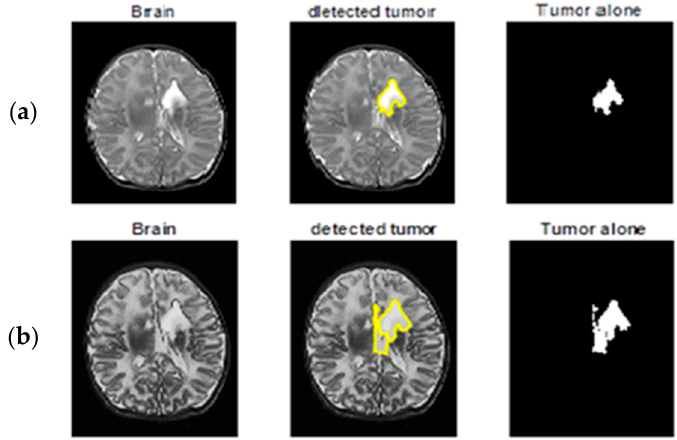
Figure 12. In the figures, the first image in the is the original image, the second image is the segmentation result of the first one, and the third image represents the extraction of the tumor succeeding segmentation. Similarly, in Figure 12, row 2 ( b ), the first figure is the preprocessed result of the original image, and the second and third images are same as above. From the third part, it is visualized with ease that the result of the tumor extraction does have more precision in the case of part ‘( b )’ compared to part ‘( a )’. Table 5. Dice Index with FCM and Proposed ARKFCM method.